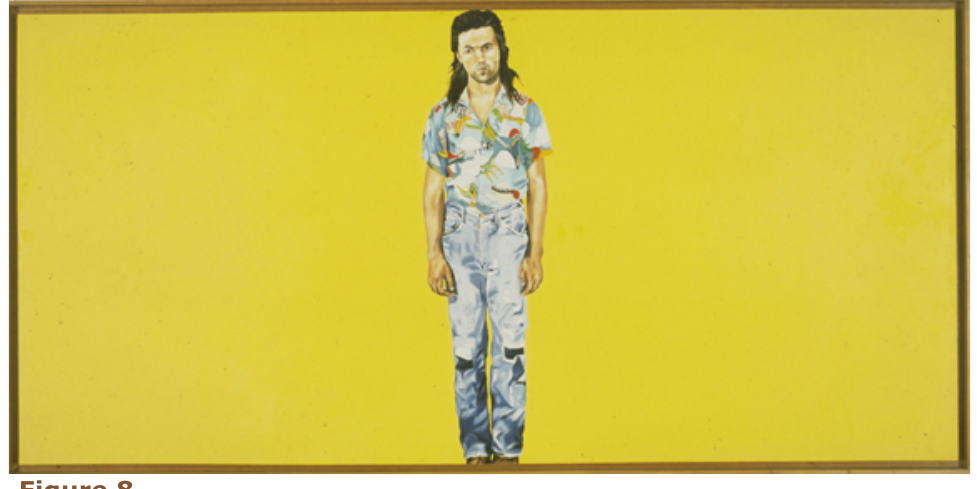
Figure 8 Jenny Watson, Yellow Painting: John , 1974, synthetic polymer on canvas, 182.5 x 380.5 cm. Monash University Collection, Melbourne. Copyright Jenny